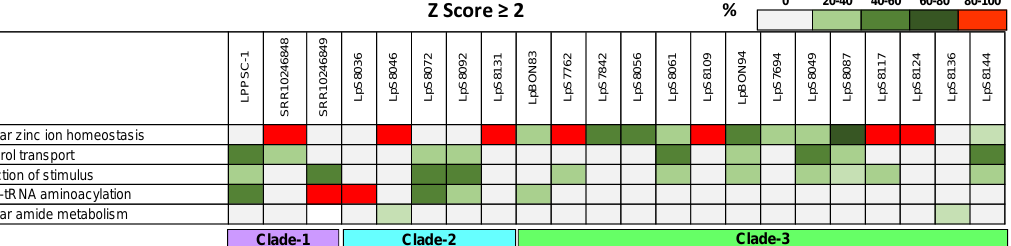
Table 2. Selected set of SNPs with synonymous variant effect or relevant impact on gene function.